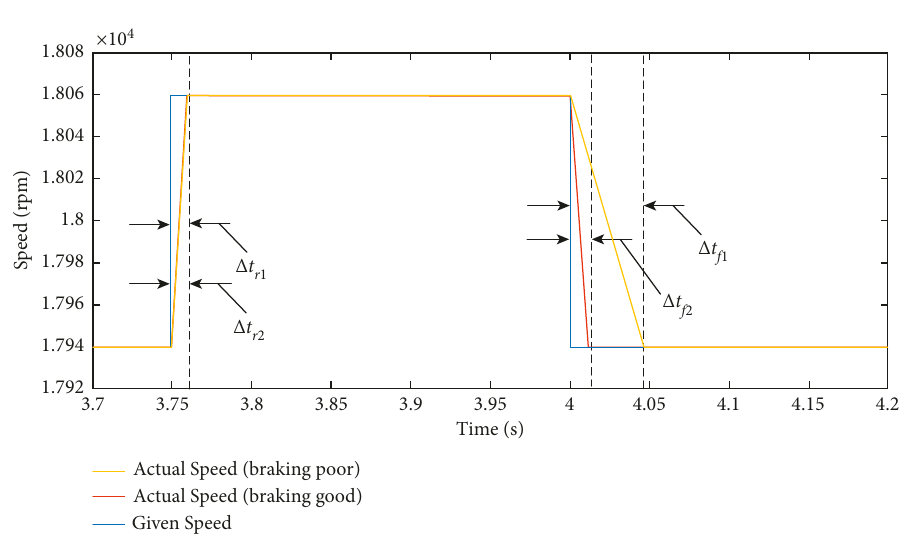
Figure 8: Speed step response diagram of RMBMA.